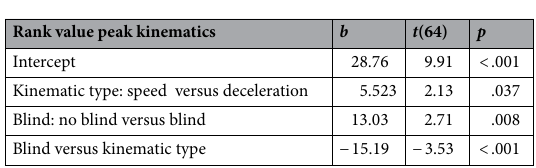
Table 4. Results mixed regression kinematic peaks and blind